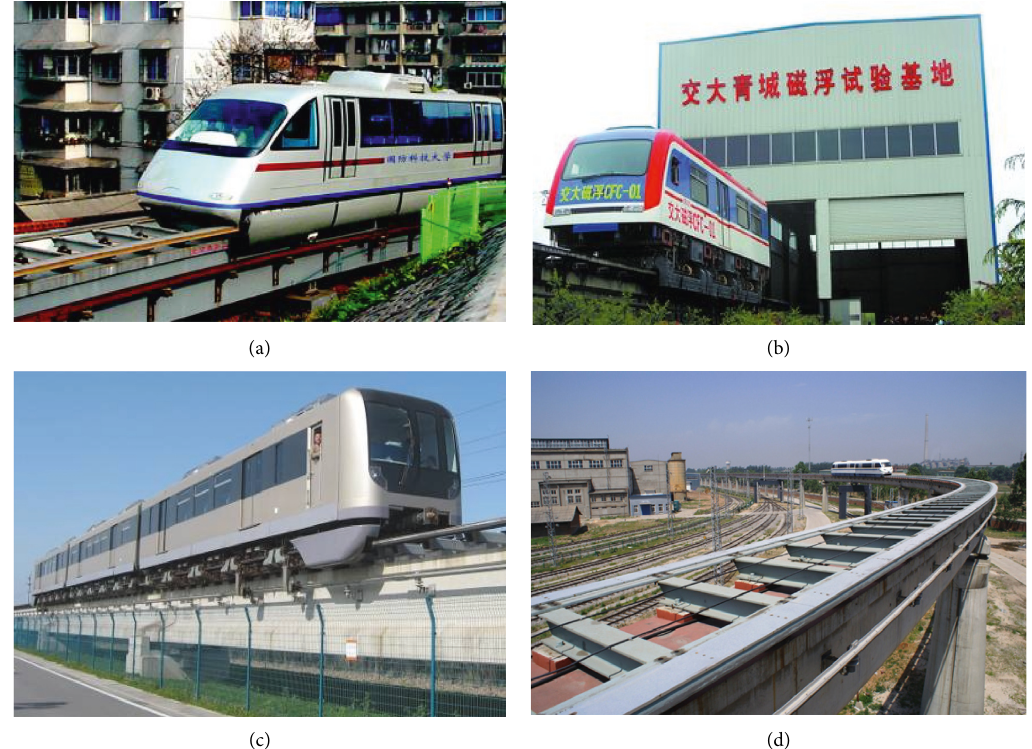
Figure 2: Mls maglev test lines: (a) Changsha test line; (b) Qingchengshan test line; (c) Shanghai Lingang test line; (d) Tangshan test line [3, 12, 33].